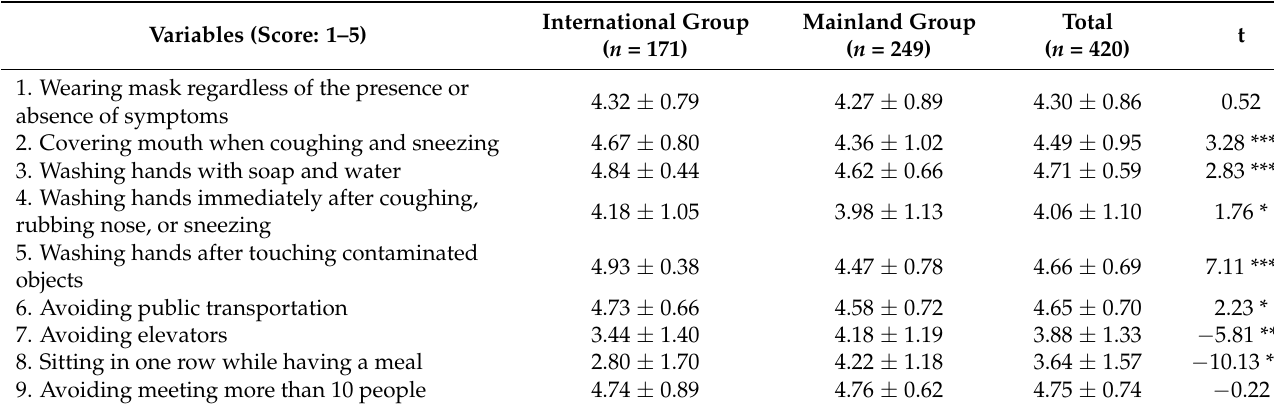
Table 3. Preventive practices taken against COVID-19 by Chinese university students in Mainland China and South Korea. (Mean ±